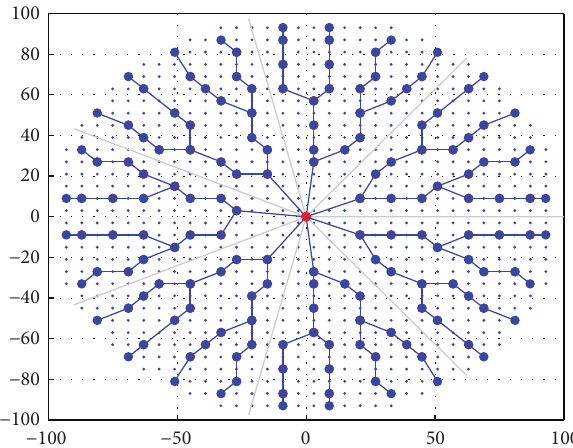
Figure 2: Routing tree: blue dots are the sensor nodes, and the red dot is the